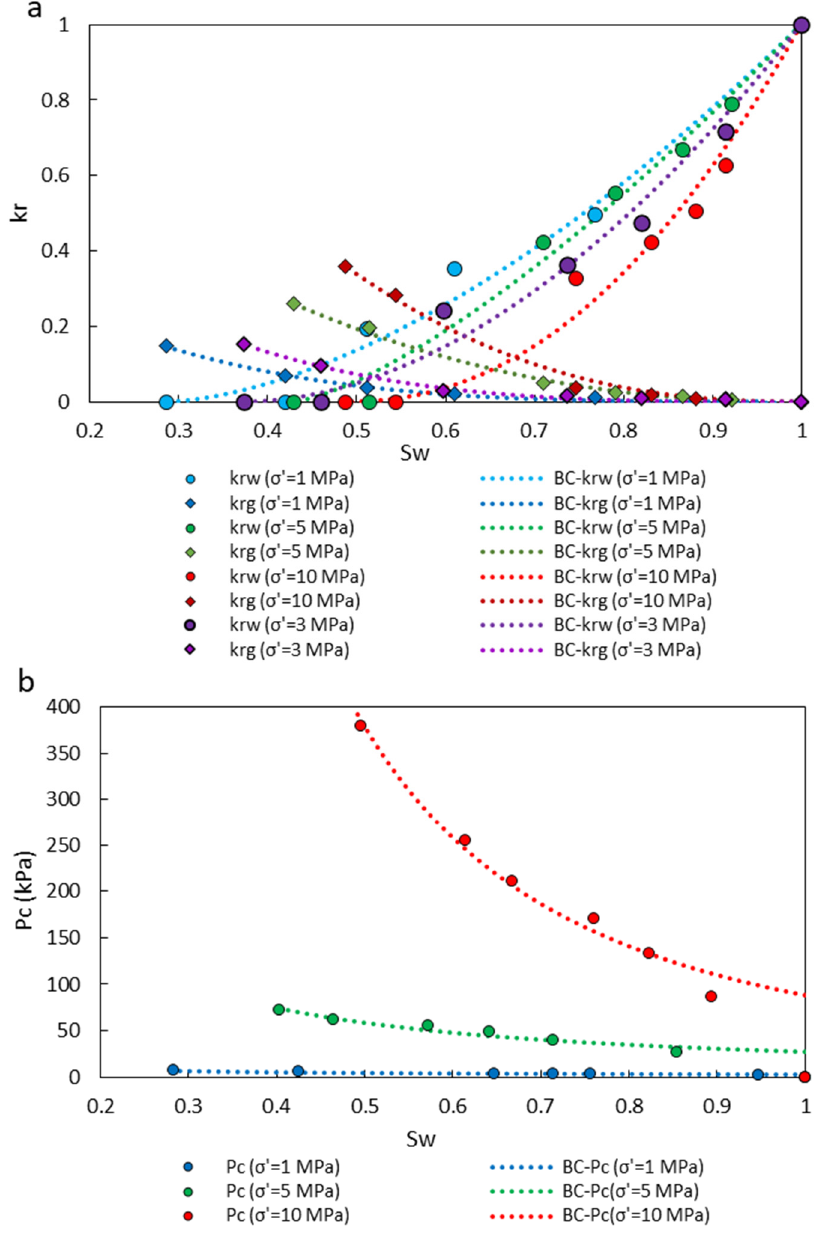
Figure 6. Experimental stress-dependent plots of: ( a ) relative permeability curves and ( b ) capillary pressure curves of the fractured Calumet carbonate specimen.